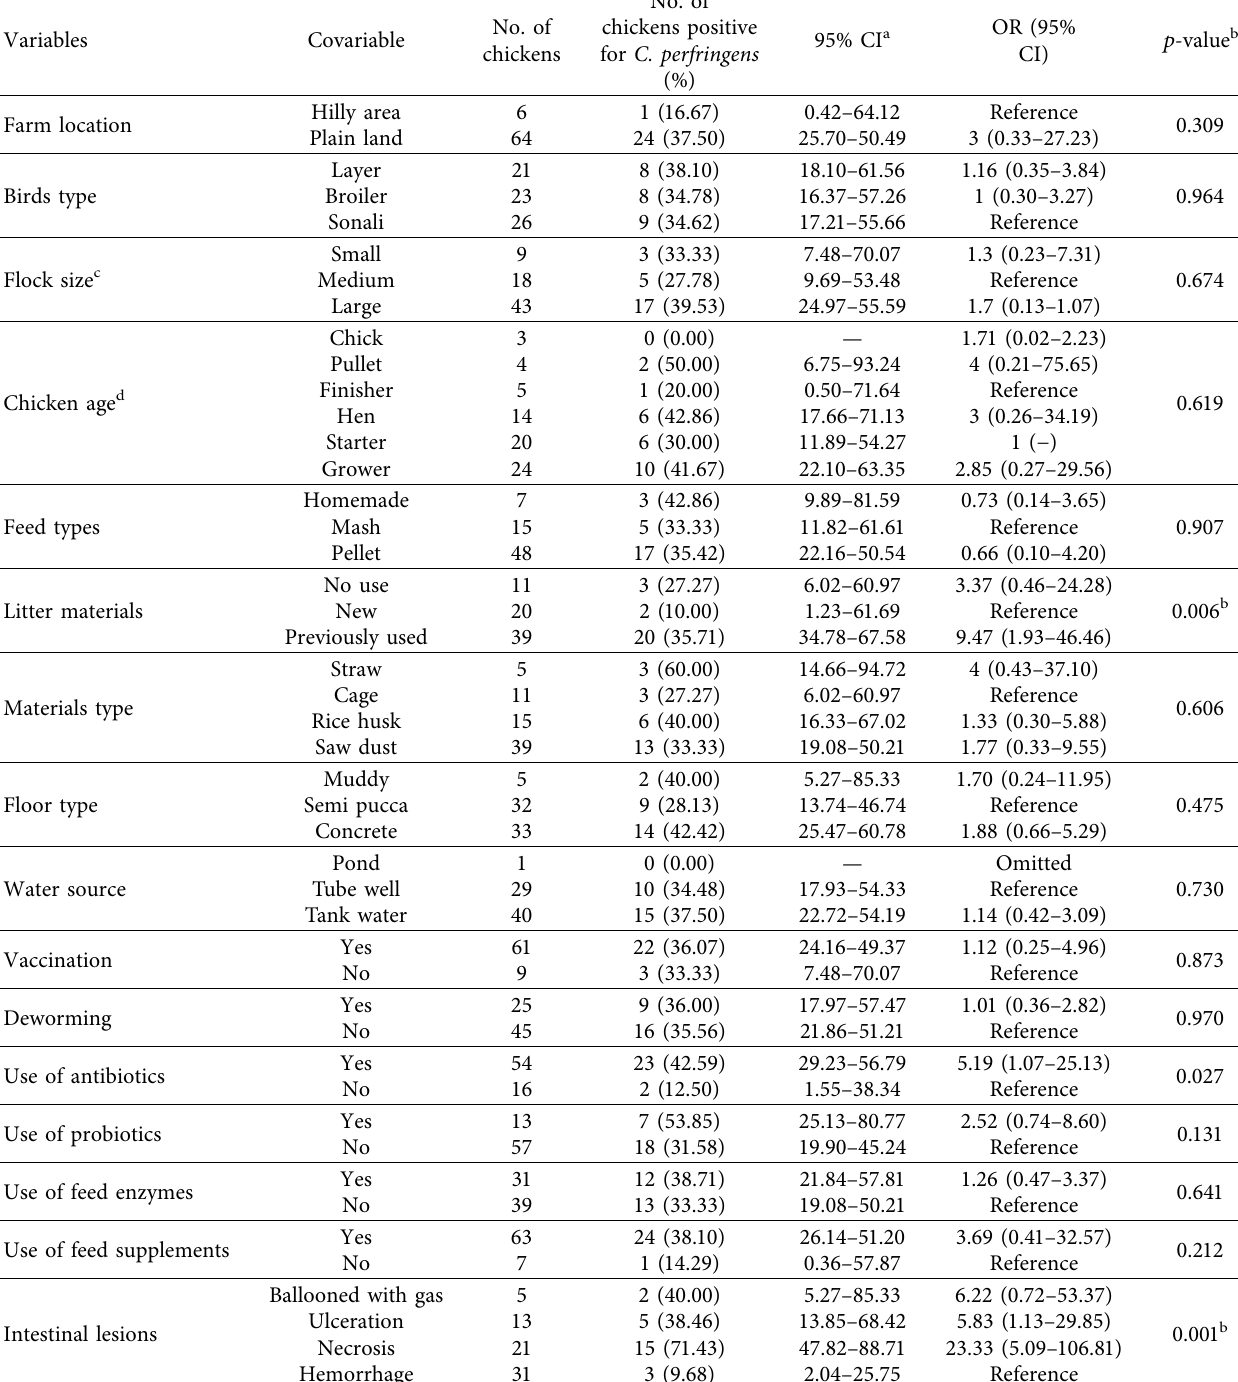
Table 3: Univariable logistic regression analysis of risk factors for the presence of C. perfringens in diseased